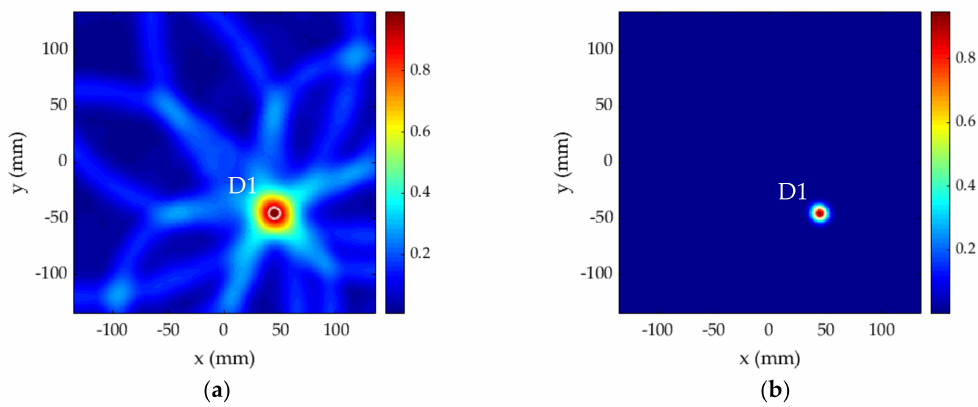
Figure 15. Time-compensated aggregate damage image for single damage scenario in pulse–echo configuration based on ( a ) compromised fusion scheme; ( b ) conjunctive fusion scheme.